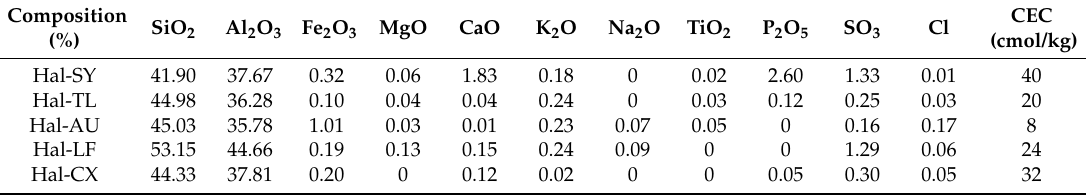
Table 1. The chemical composition and CEC values of halloysites in typical regions